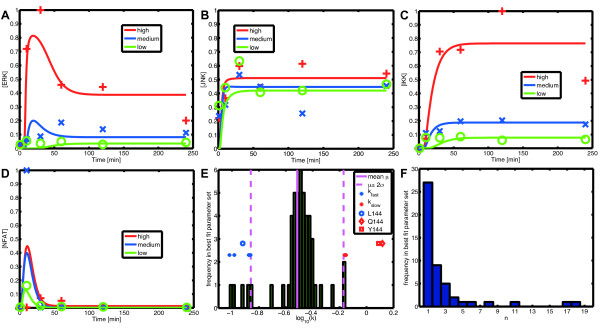
Results of the parameter fit. (A-D) Simulation of the continuous model (solid lines) for high (red), medium (blue) and low (green) concentrations of ligand L144 and experimentally measured concentrations, cf. markers '+', '×' and '○'. (A) ERK. (B) JNK. (C) NFAT. (D) IKK. (E, F) Distribution of the Hill parameters in the best fit parameter set for ligand L144 (Table 1). (E) Distribution of the thresholds k. The markers '+' indicate the position of the parameters which we set to kfast (blue) and kslow (red) at the beginning of the optimization. The marker '○' indicates the position of kL144; for comparability the thresholds kQ144 and kY144 are also indicated, cf. the markers '◇' and '□', respectively. (F) Distribution of the Hill exponents n.